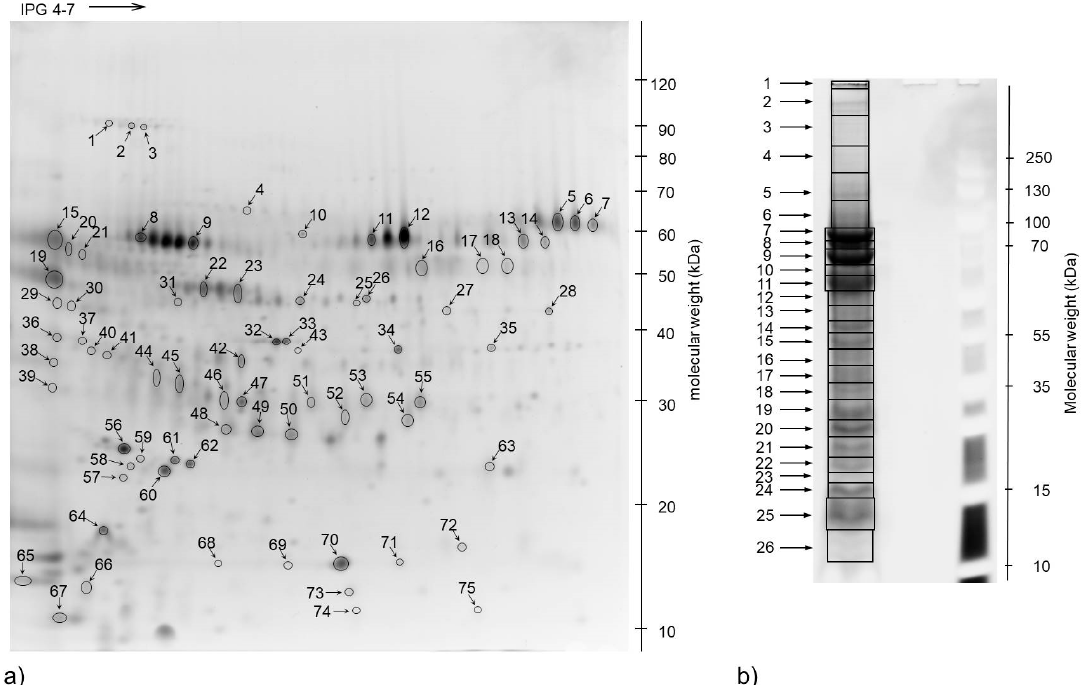
Figure 1. Representative 1-D and 2-D gels: ( a ) Two-dimensional map of calves’ urinary proteome. 2-D gel presents SyproRuby stained urine protein pattern (240 µg of proteins, 4–7 NL 18 cm IPG Strips, 12.5% poliacrylamide gel). Spot IDs correspond to the mass spectrometry identifications presented in Table S1. ( b ) One dimensional gel electrophoresis of proteins isolated from calves’ urine. Proteins were loaded at 16.67 µg per lane and proteins were detected with SyproRuby stain after electrophoresis.